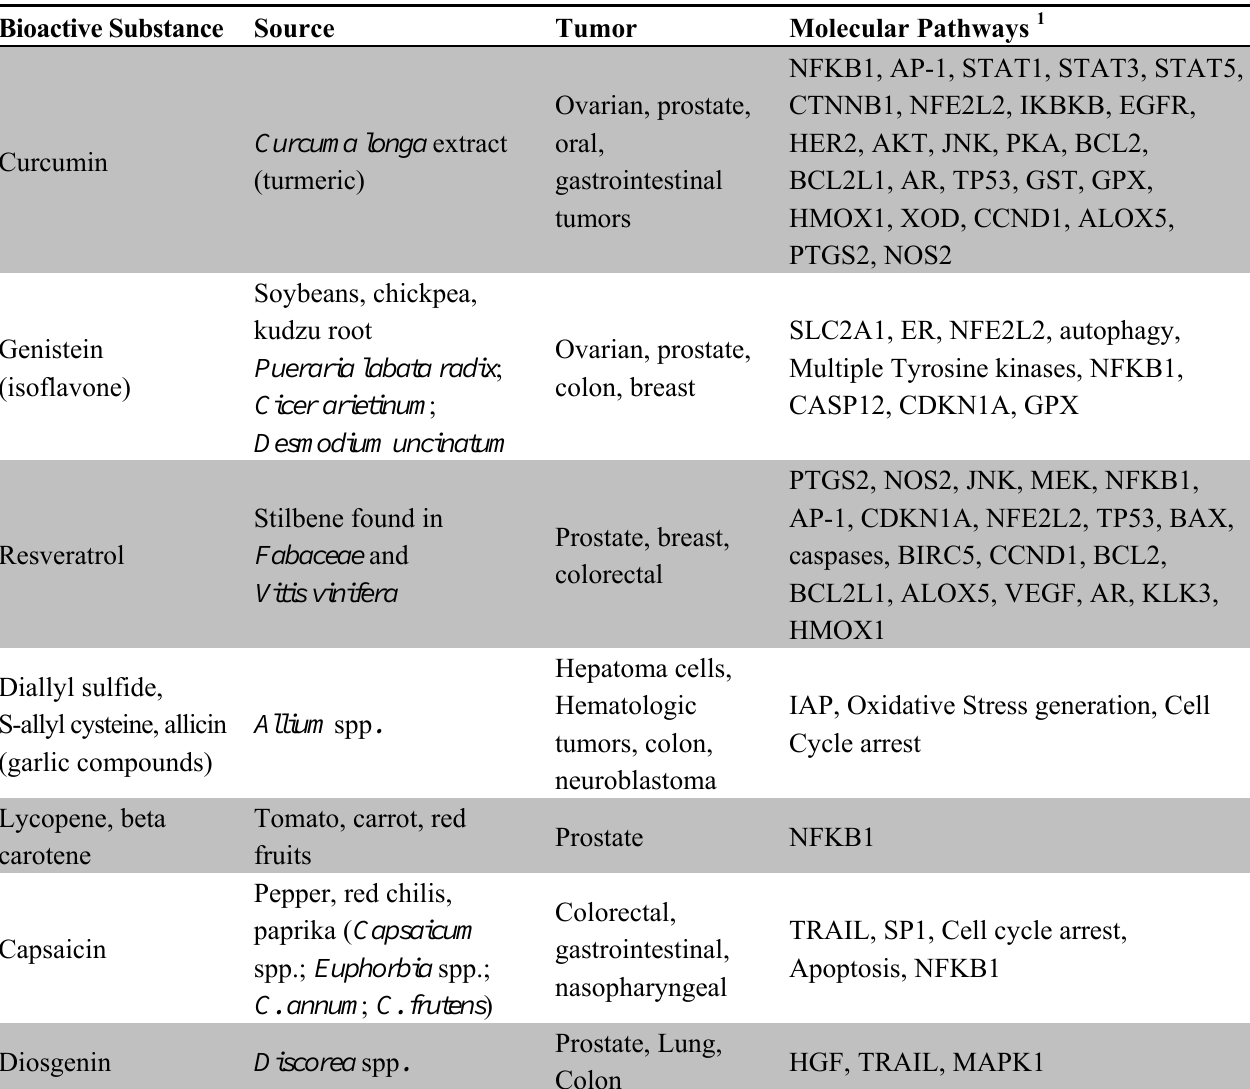
Table 1. Natural antioxidants and their molecular targets implicated in cancer